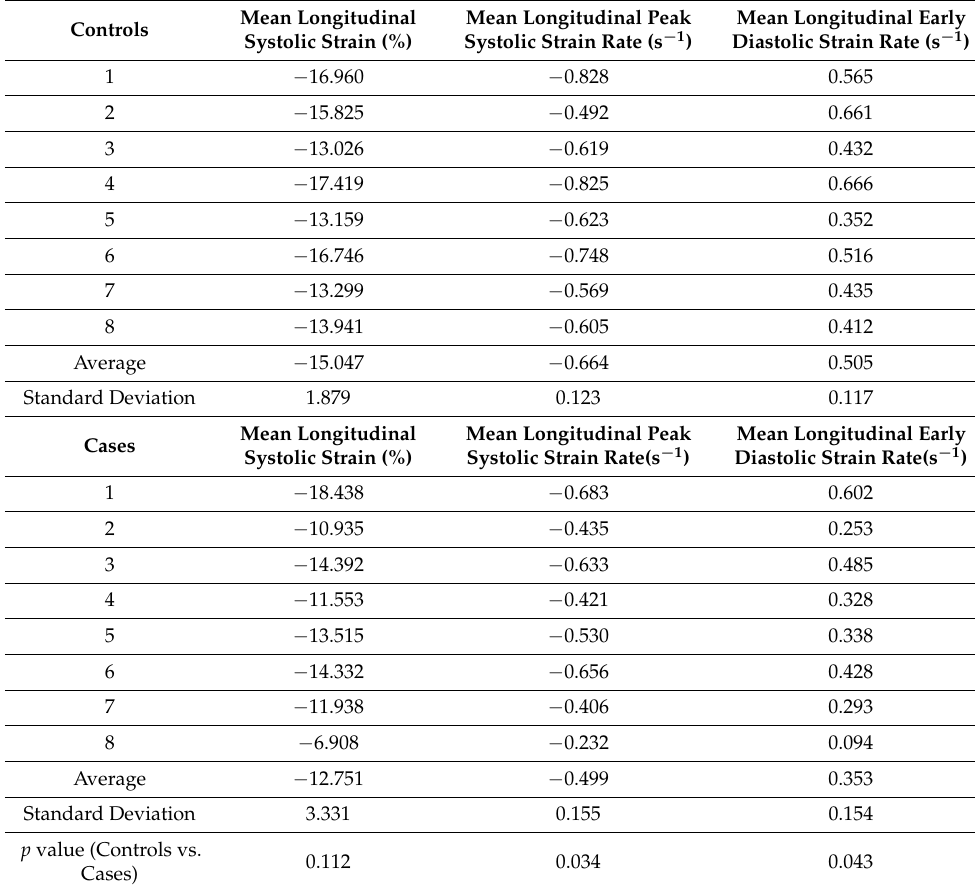
Table 6. CMR strain indices of cases vs. controls.